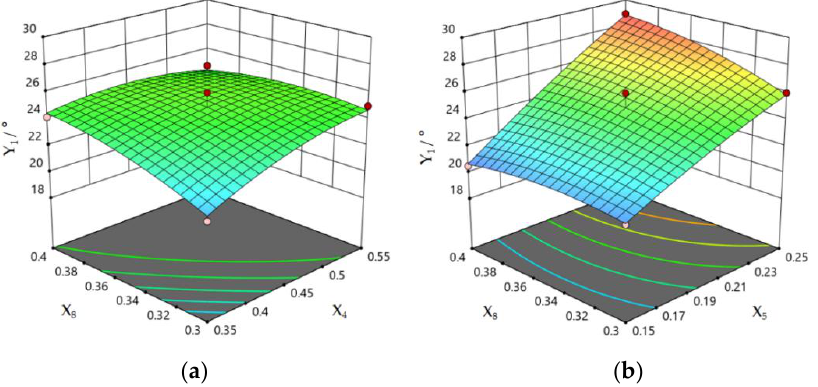
Figure 7. Effect of the interaction between factors on the degree of stacking angles: ( a ) response surface under factors X 4 and X 8 ; ( b ) response surface under factors X 5 and X 8 .